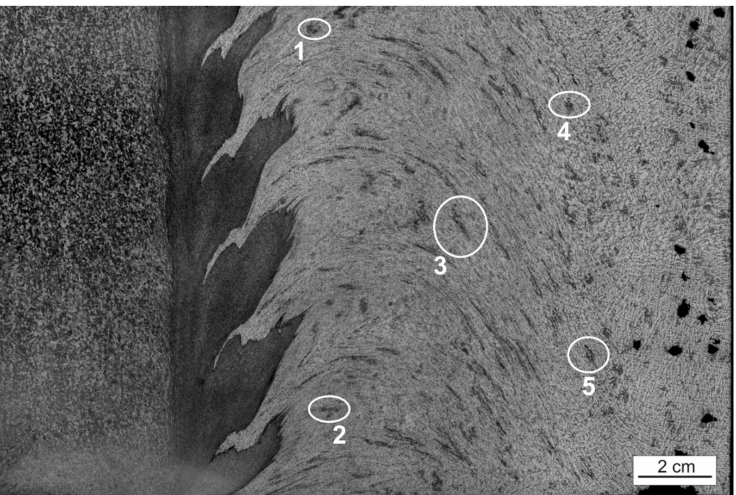
Figure 10. Highlighted specific objects ( 1 – 5 ) in the microstructure of the FSW welding joint layer.